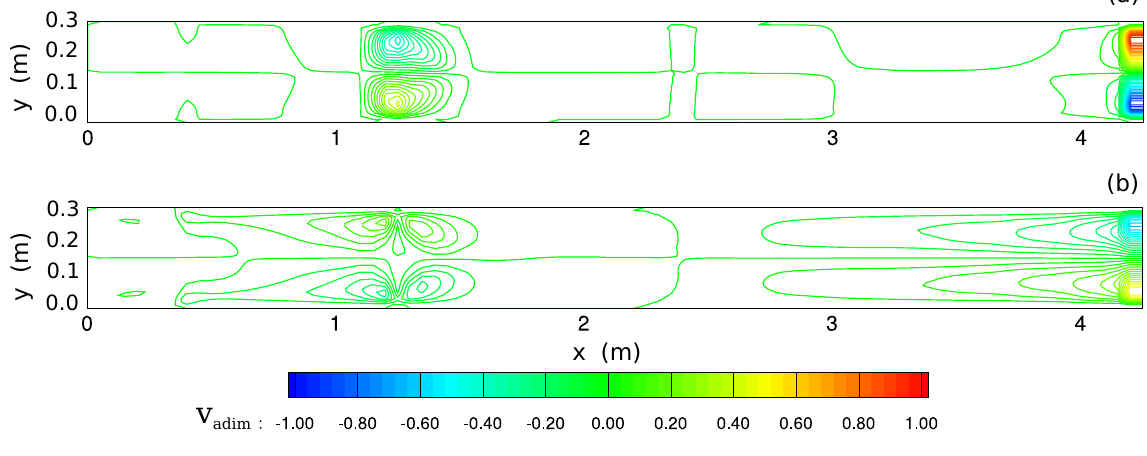
Figure 13. Channel with submerged and emergent vegetation, the V velocity component at the free surface layer ( a ) and at 0 . 038 m from the bottom ( b ); where v